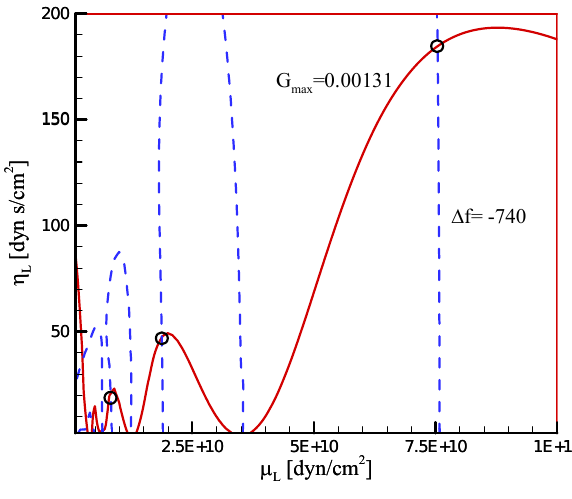
and η of a viscoelastic overlayer. Solid lines are L L = 0.0013[S] at 83 ° C max